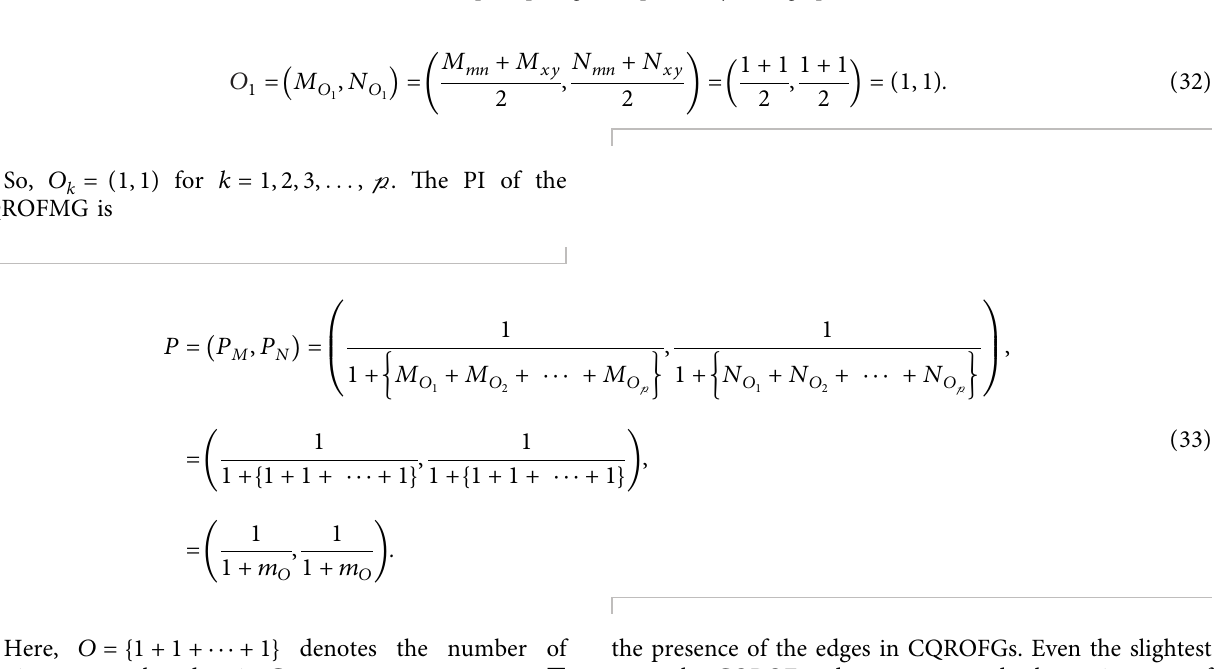
Figure 4: Complex q-rung orthopair fuzzy